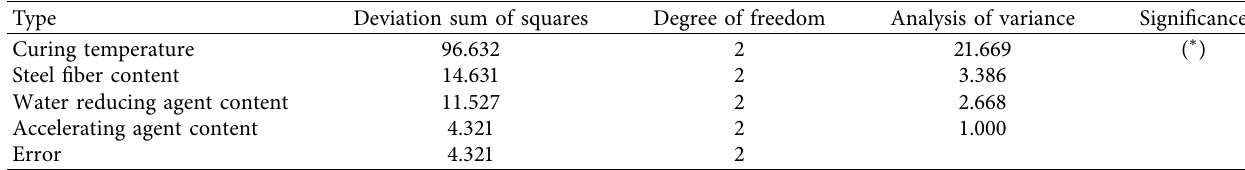
Table 10: Table of variance analysis of compressive strength of 7-day-old concrete specimen.